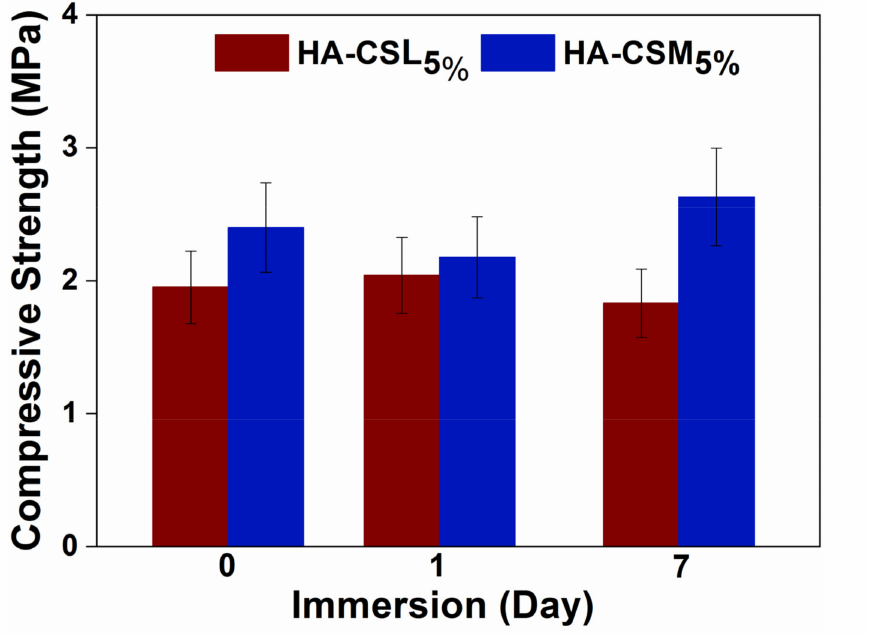
Figure 6. Compressive strength of the HA-CSL 5% and HA-CSM 5% composites after immersion in KCl (1 mM) aqueous